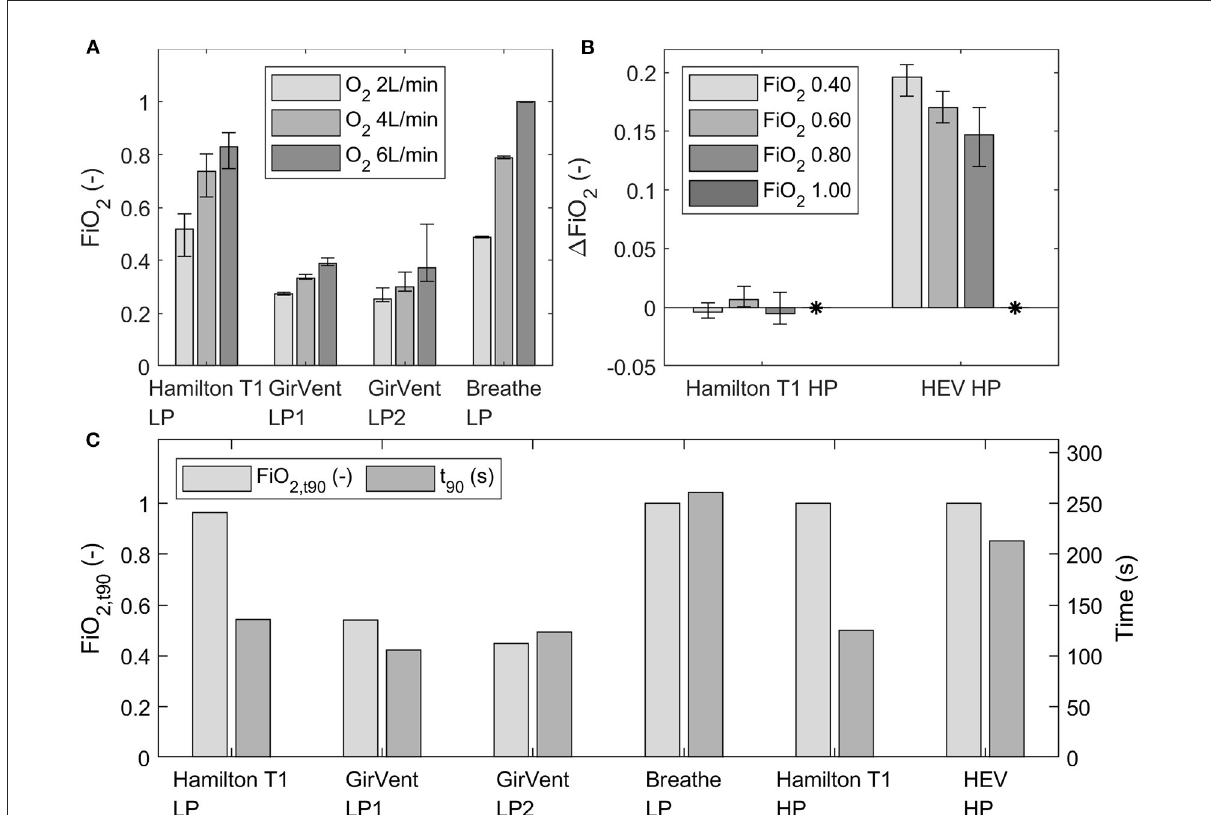
FIGURE6 (A) Mean FiO 2 at three O 2 flow rates (2L min − 1 , 4L min − 1 , and 6L min − 1 ) for the ventilators with low-pressure O 2 supply, depicted over the last 30s of steady state. (B) Measured 1 FiO 2 in the Hamilton T1 and HEV (high-pressure port) to the set FiO 2 concentrations in the UI (0.40, 0.60, 0.80 and 1.00). The measured 1 FiO 2 with an FiO 2 setting of 1.00 in the UI is indicated by * . The error bars indicate the fluctuation (minimum and maximum) observed at steady state. (C) Achieved FiO 2 , and t 90 values at an O 2 flow rate of 12 L/min (low pressure) or at a set O 2 concentration of 100% (high pressure) of each